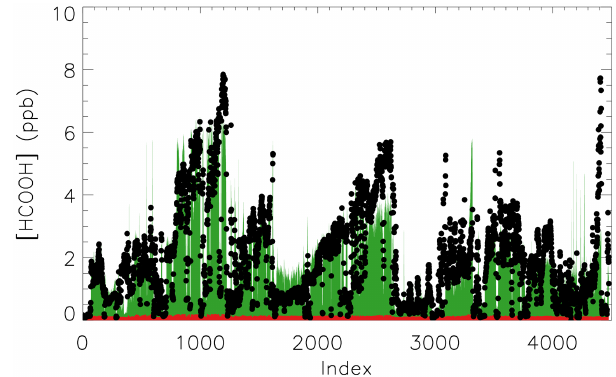
Figure 5. Source partitioning of atmospheric HCOOH based on a regression against methanol (as a biogenic tracer) and MEK (as a predominantly anthropogenic tracer) during the SENEX aircraft campaign. The figure shows the resulting attribution of the mea- sured HCOOH abundance (black) to biogenic (green) and other (an- thropogenic + background; red) sources.